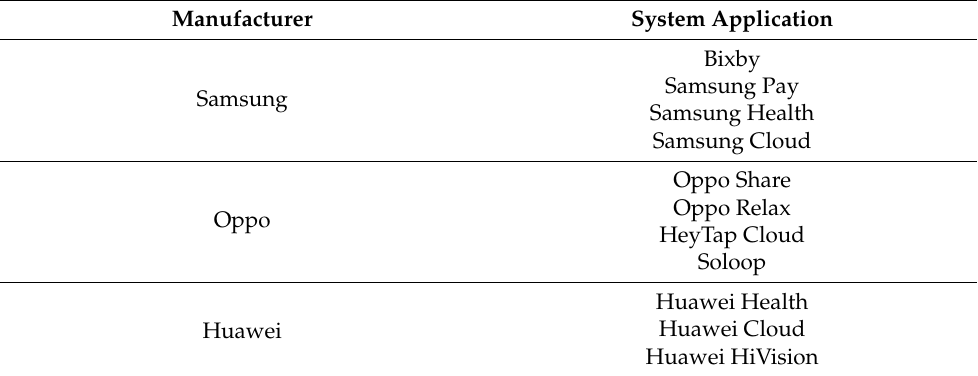
Table 2. Built-in system